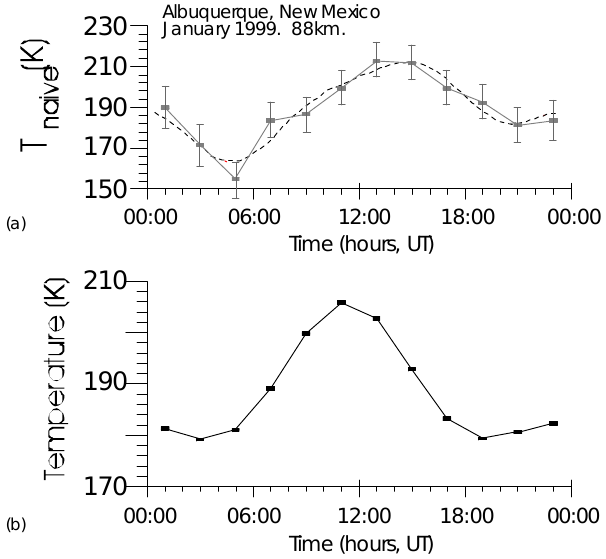
Fig. 1. (a) Graph showing the mean “naive” temperature as a func- tion of time of day for a composite day for January 1999 over Al- buquerque, New Mexico. A best fit diurnal plus semidiurnal plus terdiurnal curve is also shown. (b) “True” temperature versus time of day after compensation for the introduction of artificial higher order modes that arise as a result of effects associated with the daily variation of the temperature gradient in the extraction of meteor- derived